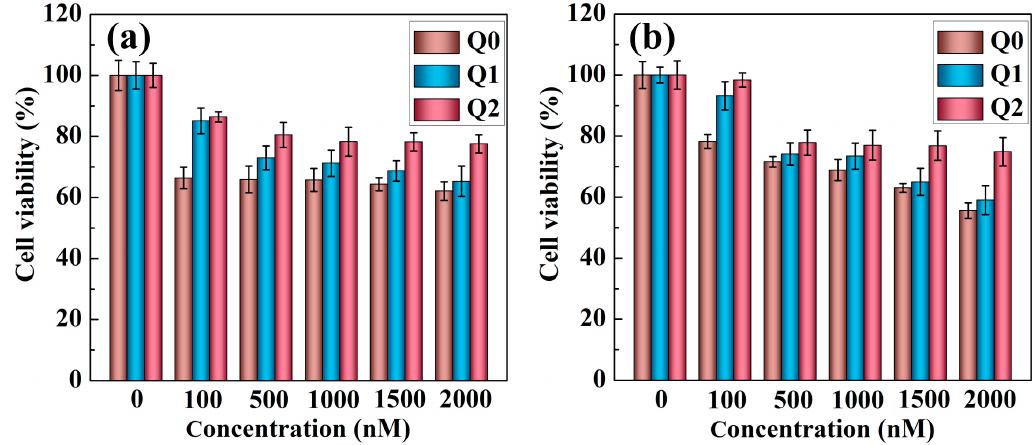
Figure 4. MTT viability assay of Uppsala 87 Malignant Glioma (U87MG) cells treated with the vector/Bcl-2 siRNA ( a ) and vector/VEGF siRNA; and ( b ) polyplexes under distinct vector concentrations (mean ± SD, n = 6).